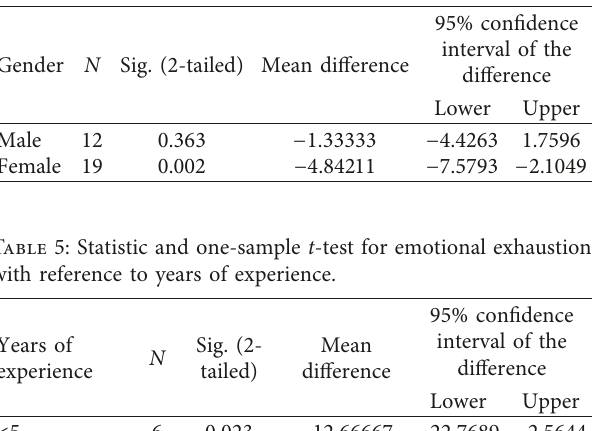
Table 4: Statistic and one-sample t -test for reduced personal ac- complishment with reference to gender.